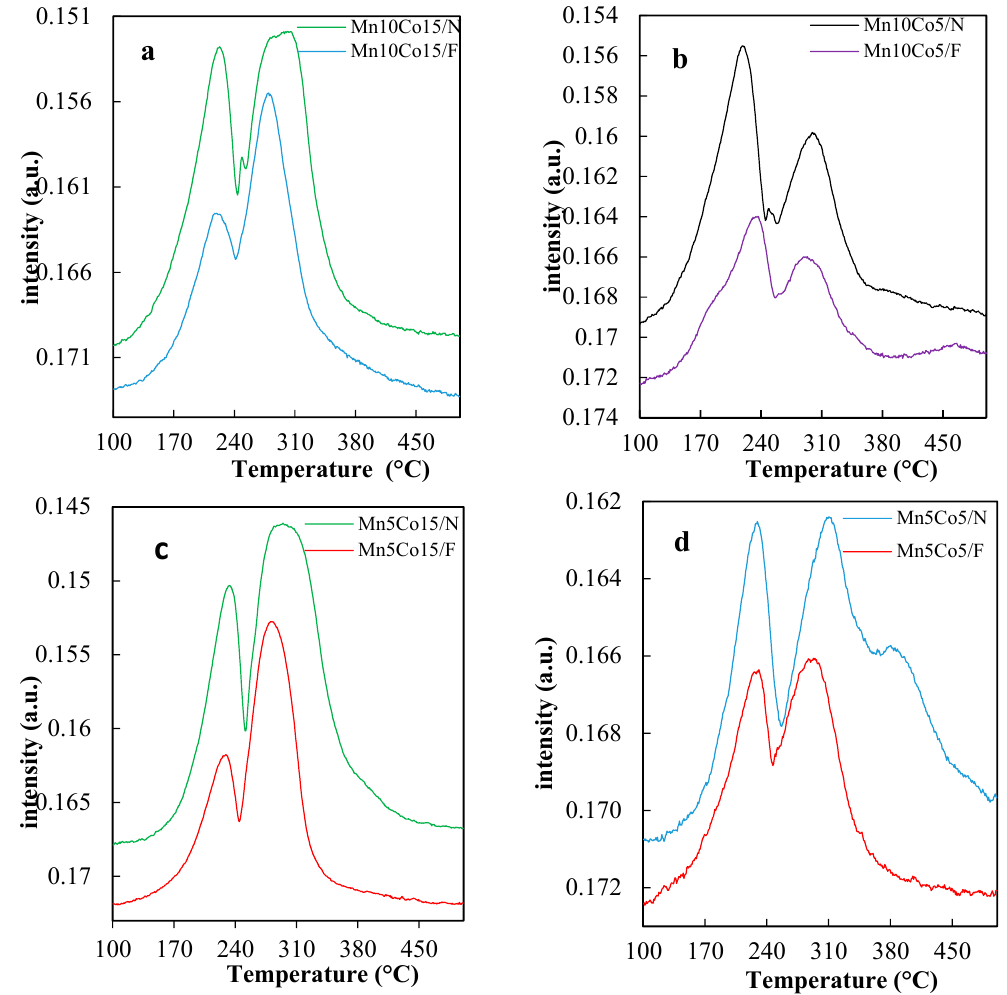
Figure 5. Comparison of the reduction profiles of ( a ) Mn 10 Co 15 , ( b ) Mn 10 Co 5 , ( c ) Mn 5 Co 15 , and ( d ) Mn 5 Co 5. Table 2. Comparison of the total hydrogen consumption of the analyzed samples.